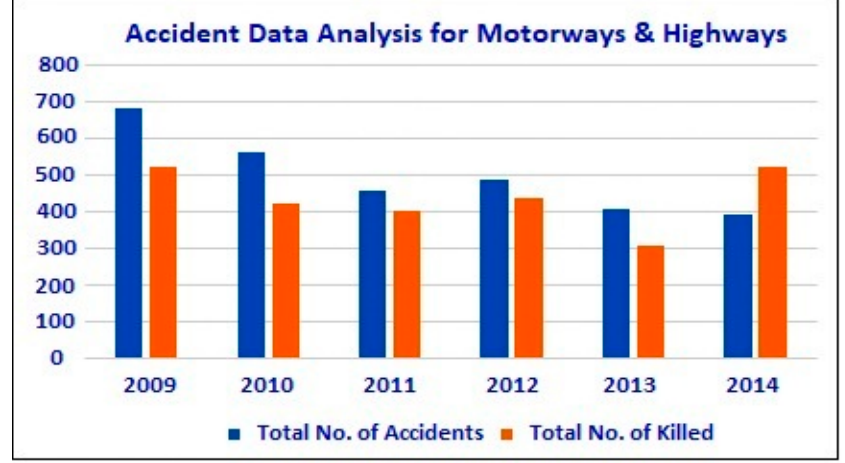
Figure 2. Accident statistics of motorways and highways of Pakistan (Source NH and MP [93]).